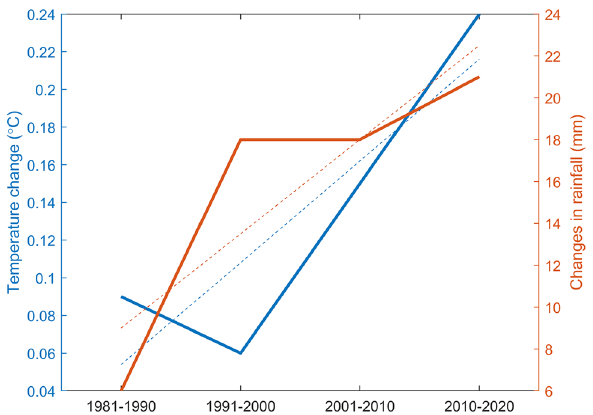
Figure 4. Changes in temperature (blue line) and rainfall (yellow line) relative to the base period